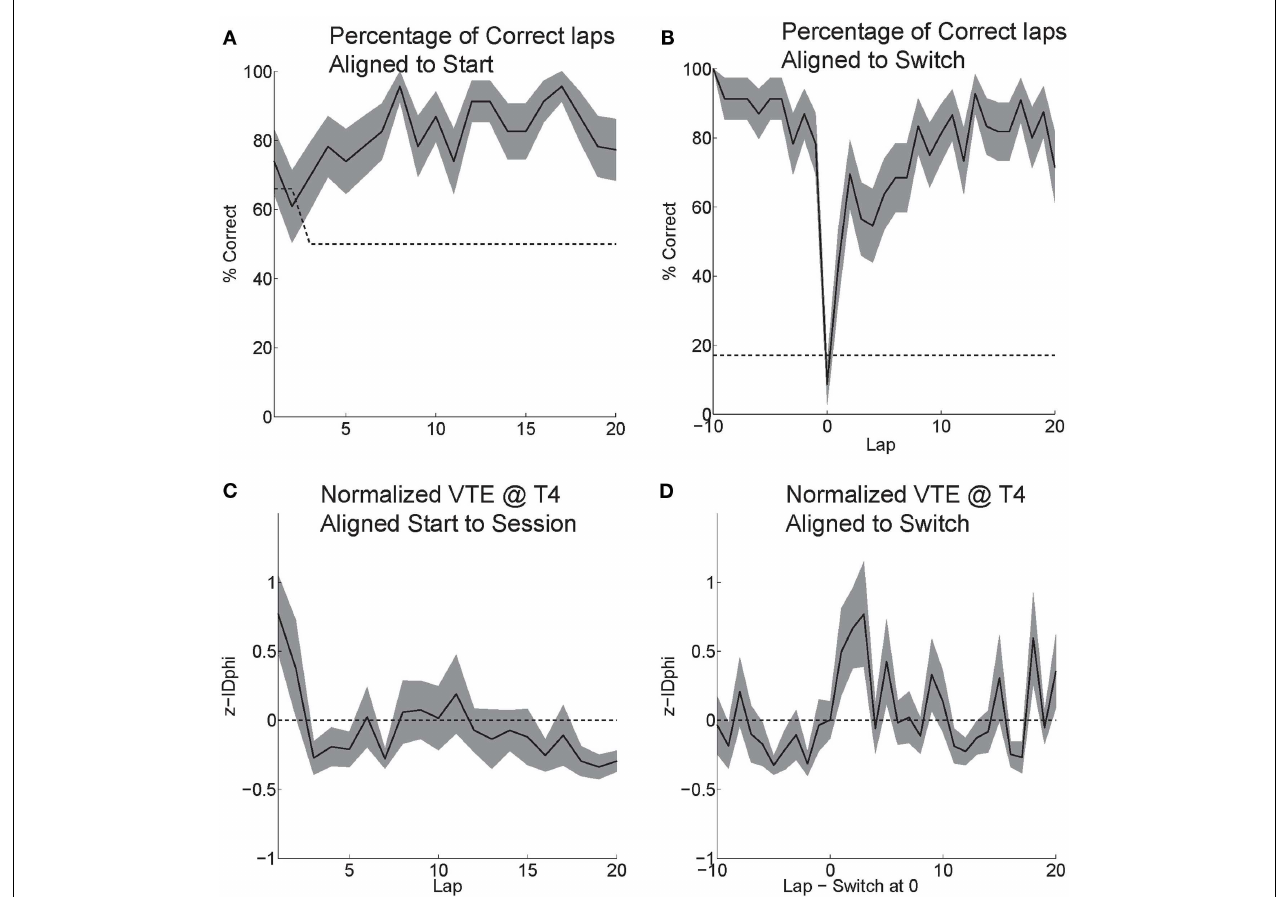
first-half-session strategy, dashed line). Rats were not aware of the time of the contingency switch or of the new, correct contingency. (C) VTE ( zIdPhi ) from the start of each session by lap.There was a significant effect of early laps onVTE (ANOVA laps 1–5, F = 4, P < 0.01). (D) VTE following the switch was significantly higher than scores prior (Wilcoxon, P < 0.01). Comparing the five laps pre switch to the five laps post-switch demonstrated a significant interaction ofVTE and lap (ANOVA F = 3, P < 0.01).